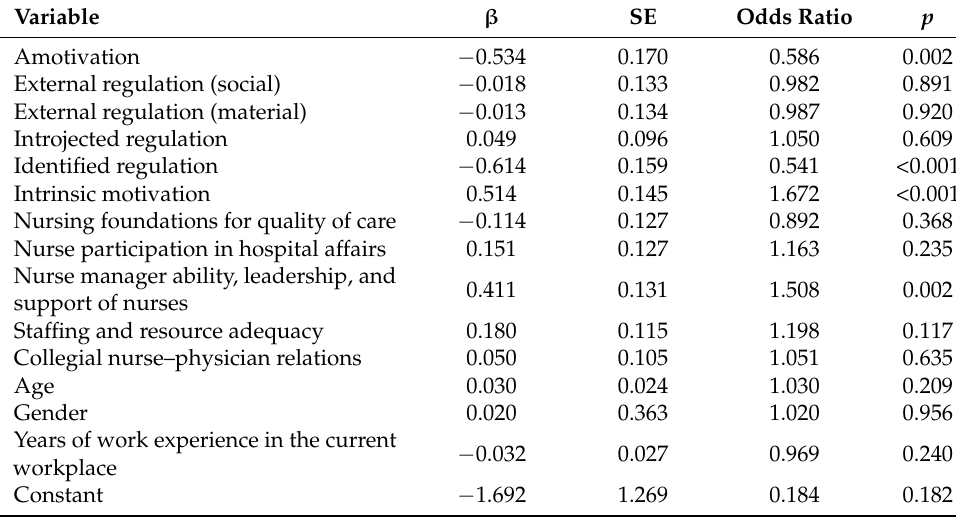
Table 3. Binary regression prediction model for job